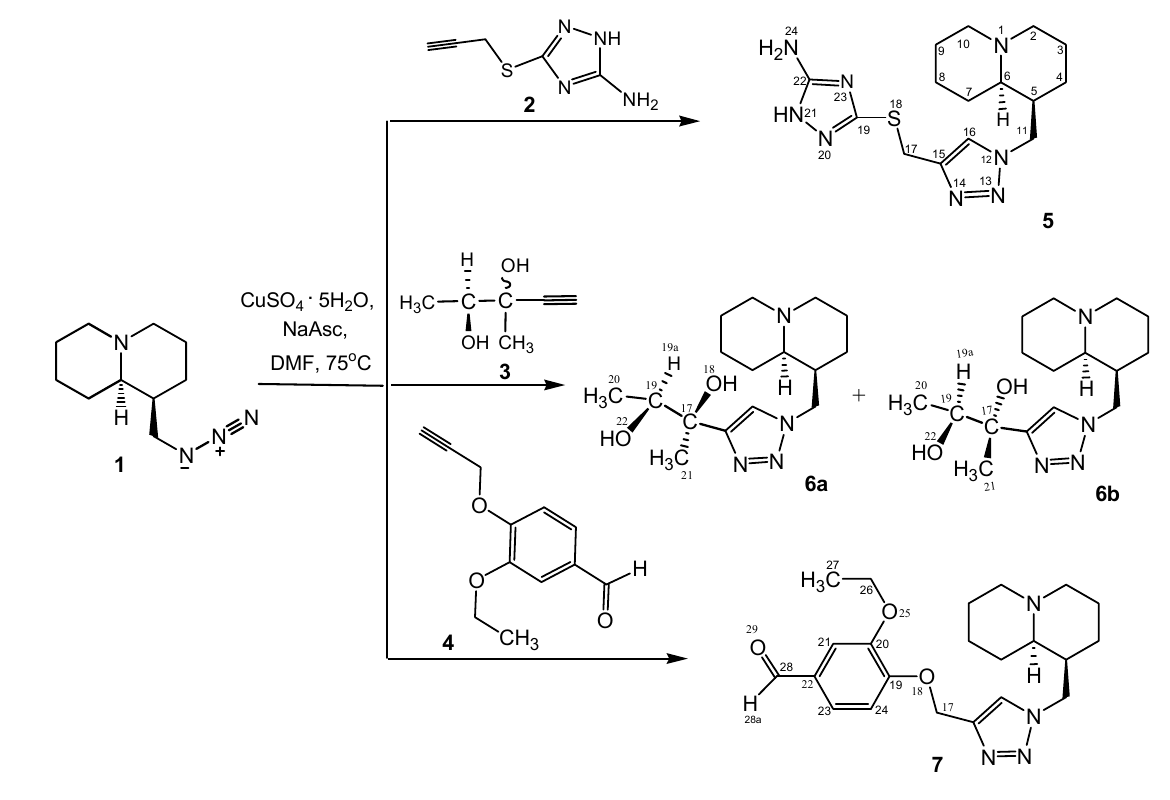
Table 1. AChE inhibitory activity of lupinine-based triazole derivatives. N